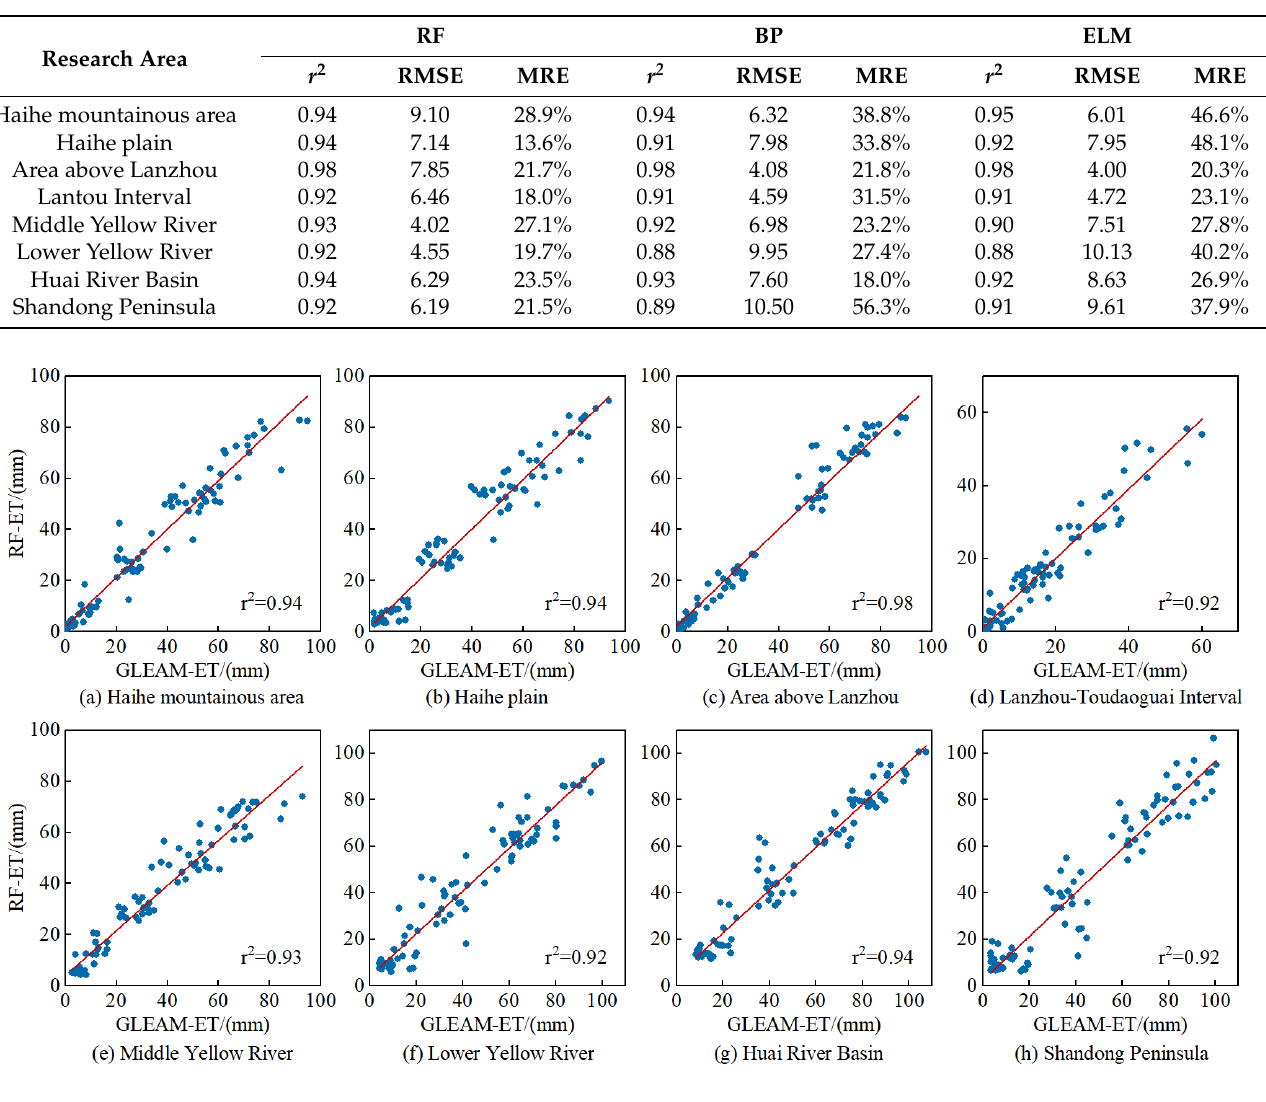
Table 3. Comparison of simulation results of machine learning test set.